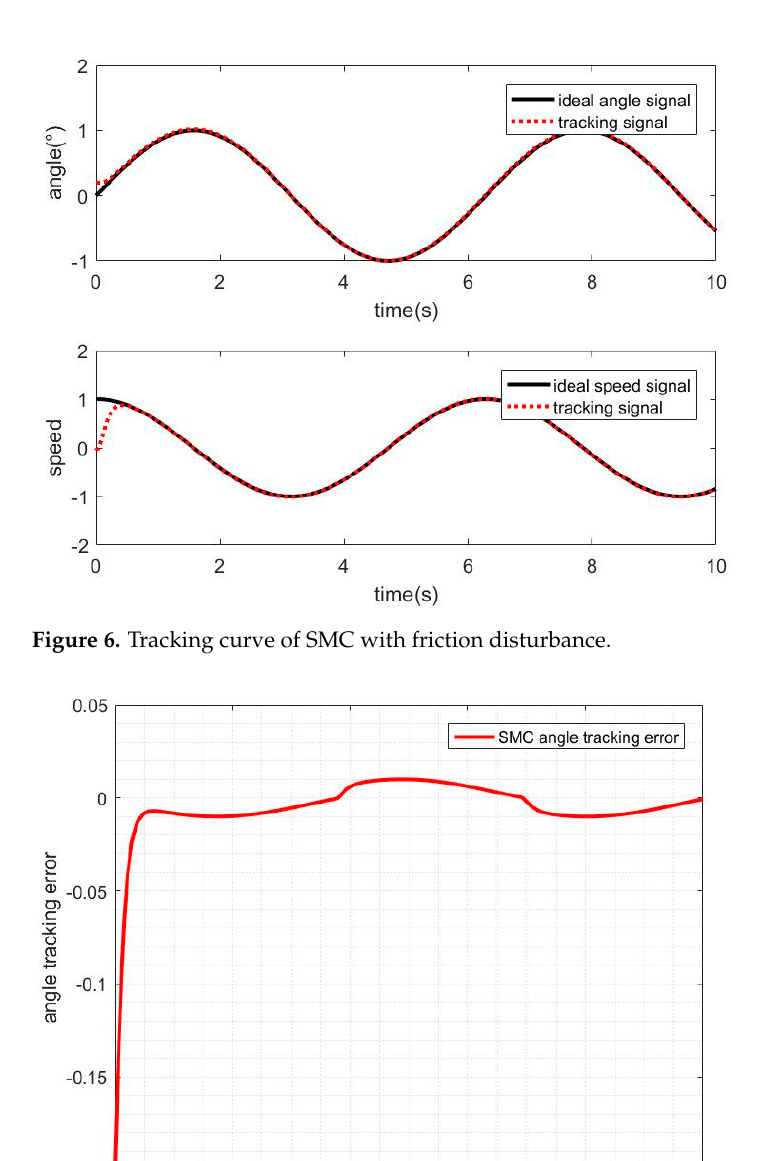
Figure 8. Approximation curve of RBF −− NN to frictional disturbance torque.